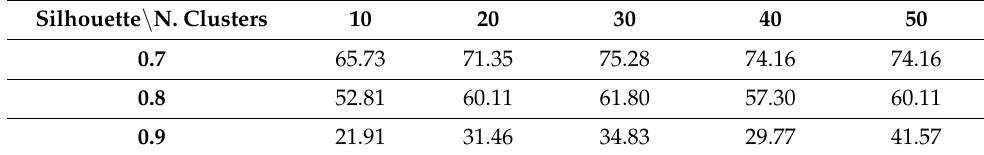
Table 27. Clustering performance in terms of silhouettes using the reduced dataset with SPQR. Silhouette \ N. Clusters